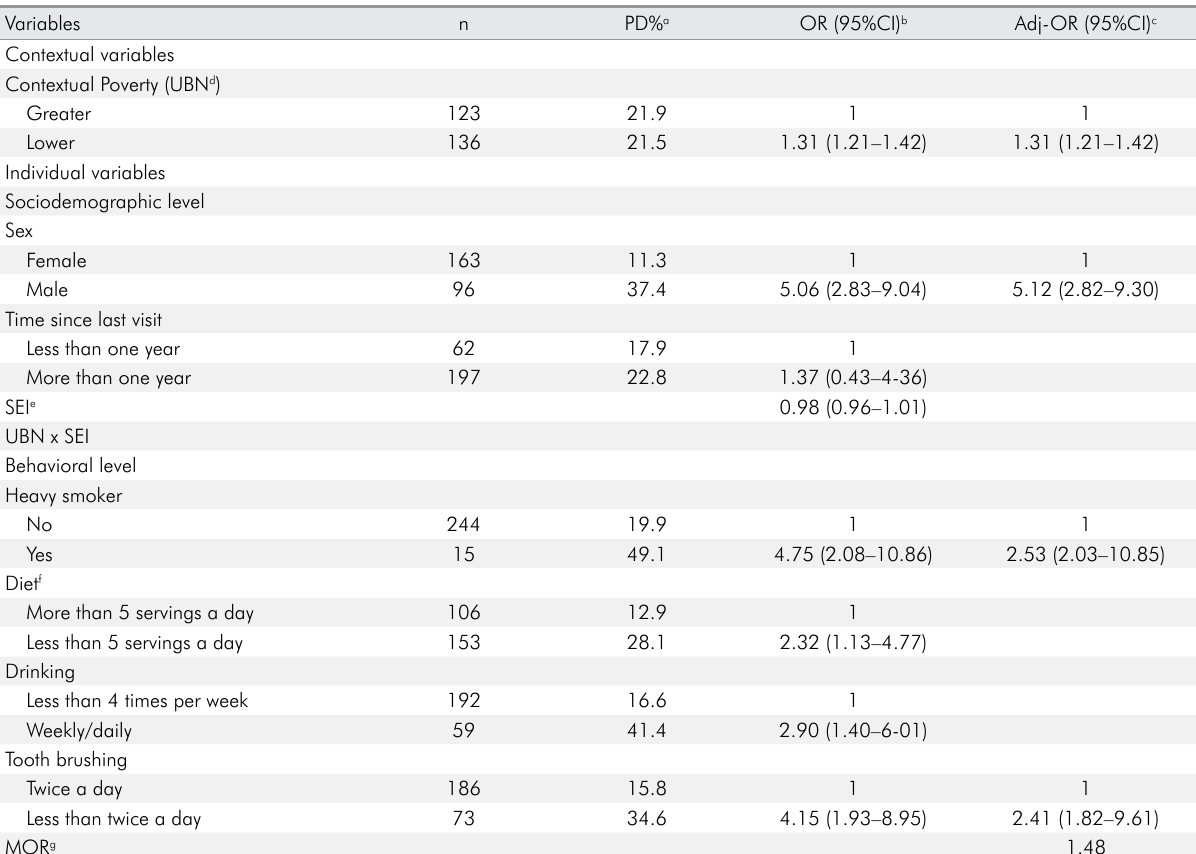
Table 2. Prevalence, and unadjusted and adjusted OR between periodontal disease (PD) and risk factors in the 65–74 age group.